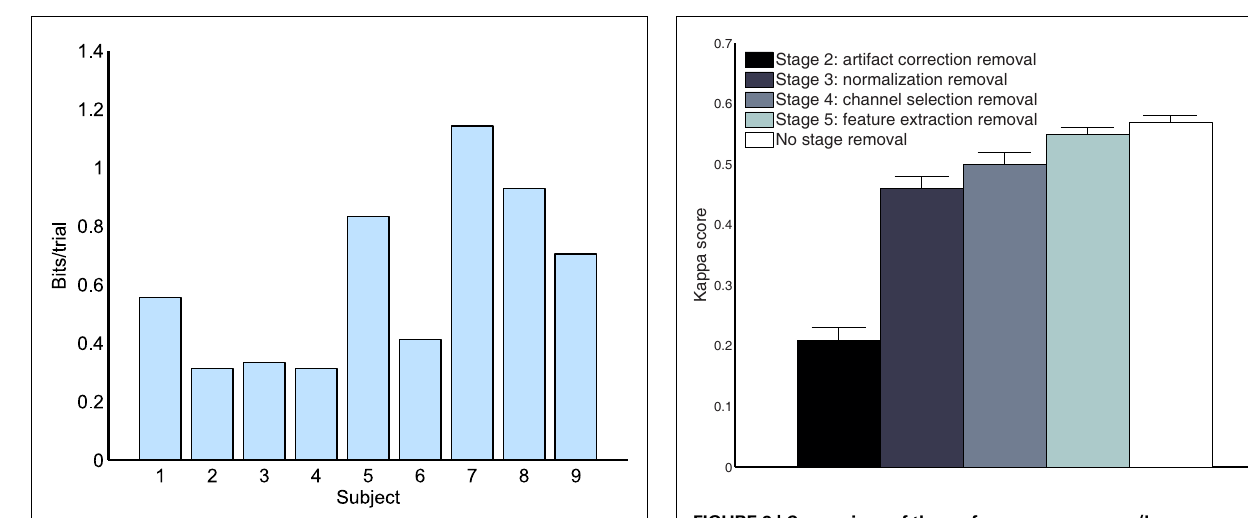
FIGURE 8 | Comparison of the performance measures (kappa scores) for different processing stage removal across all subjects on the test set (session 2).